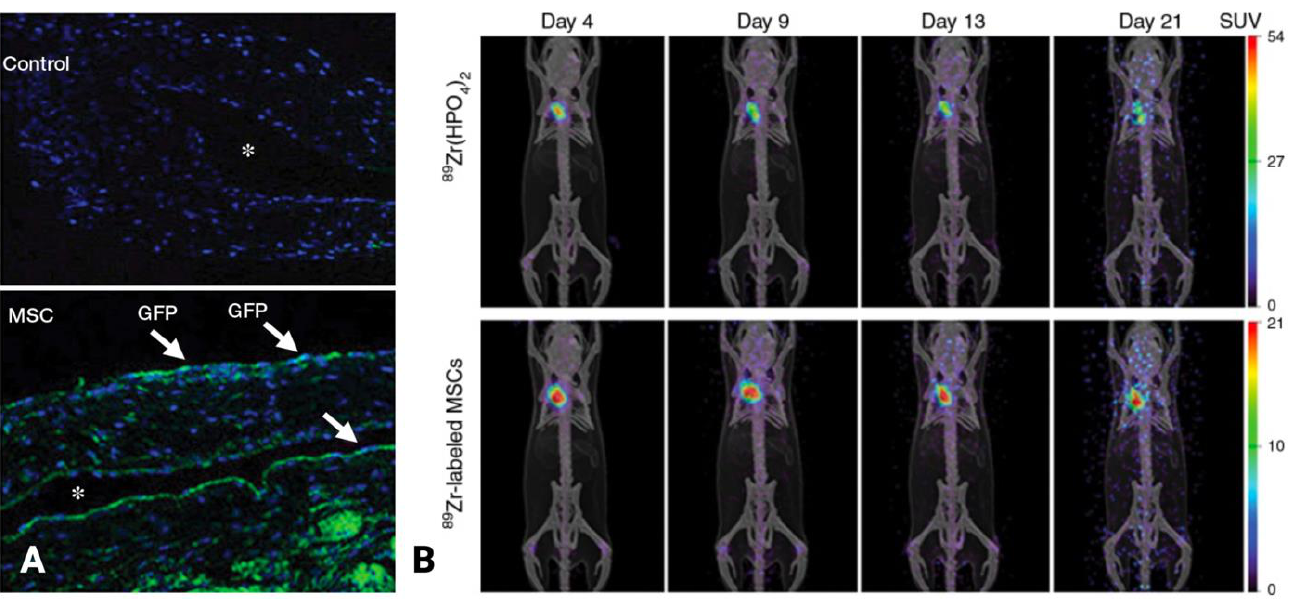
Figure 8. ( A ) Photomicrographs (original magnification, 20 × ) show the localization of GFP-labeled human adipose tissue-derived MSCs (arrows) 7 days after injection into the adventitia of the outflow vein; ∗ = lumen. ( B ) Serial PET images of 89 Zr distribution in mice after adventitial delivery of 89 Zr- labeled MSCs or 89 Zr (HPO 4 ) 2 . The anatomic reference skeleton images are formed using the mouse atlas registration system algorithm with information obtained from the stationary top-view planar x-ray projector and a side-view optical camera. SUV = standardized uptake value. Images were adapted from Yang et al. (2015) [61].